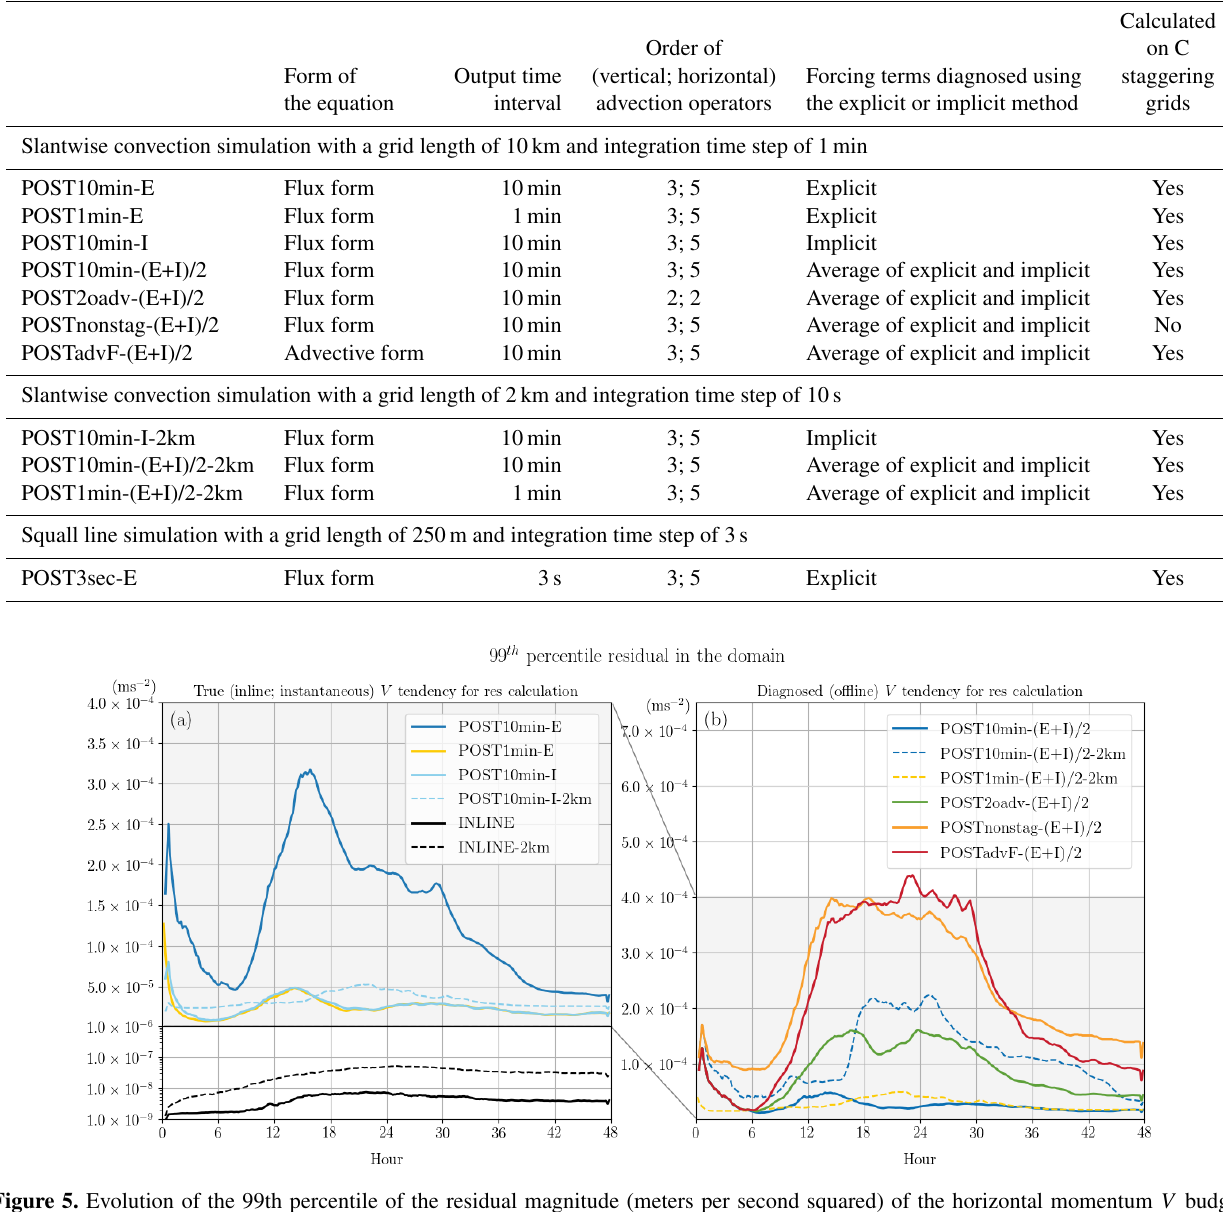
val of 2 × (cid:49)y instead of (cid:49)y , with larger associated truncation